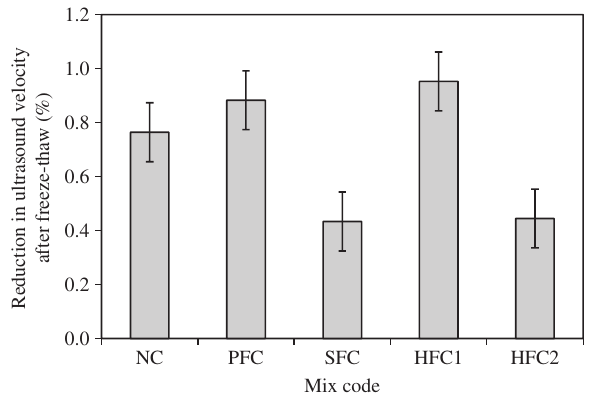
Figure 6 Changes in ultrasound velocity of concrete series sub- jected to freeze-thaw.